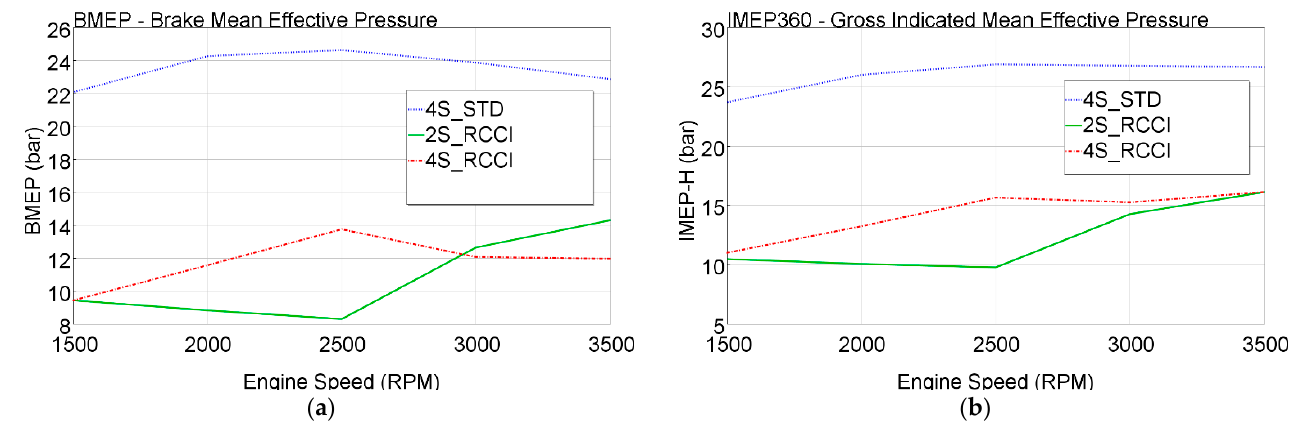
( b ) Figure 9. Brake torque ( a ) and brake power ( b ) comparison, base diesel engine, 4-stroke RCCI engine